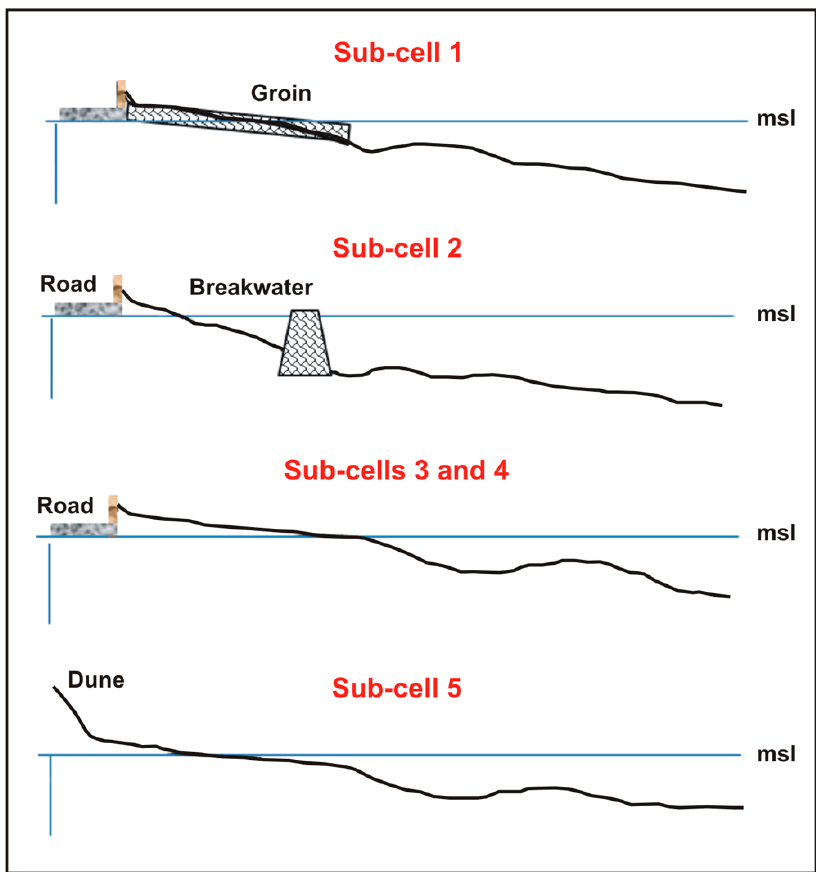
Figure 2. A simplified sketch of the emerged and submerged beach profiles along the 5 sub-cells within the study area (not in scale). The shoreline along Sub-cells 1 and 2 is about 62% and 85% armored, respectively, whereas it is just 22% in Sub-cell 5. Conversely, Sub-cells 3 and 4 have no protection structures. The blue, horizontal line represents the mean sea level (msl).